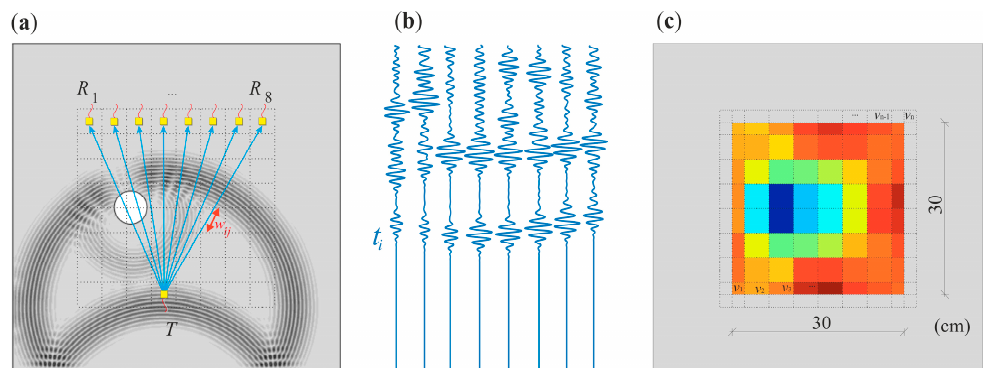
Figure 1. Schematic diagram of velocity reconstruction using ultrasound tomography: ( a ) plate with indicated receivers ( R ), transmission ( T ) points and simulated wave field; ( b ) guided wave propagation time signals; ( c ) ultrasound tomography map.